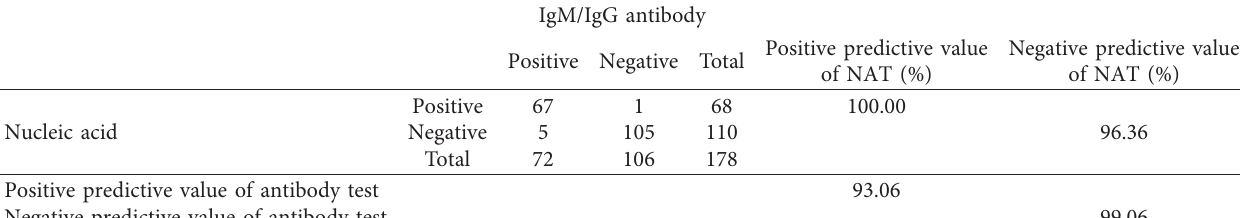
Table 3: Comparison of SARS-CoV-2 IgM/IgG antibody detection and SARS-CoV-2 nucleic acid